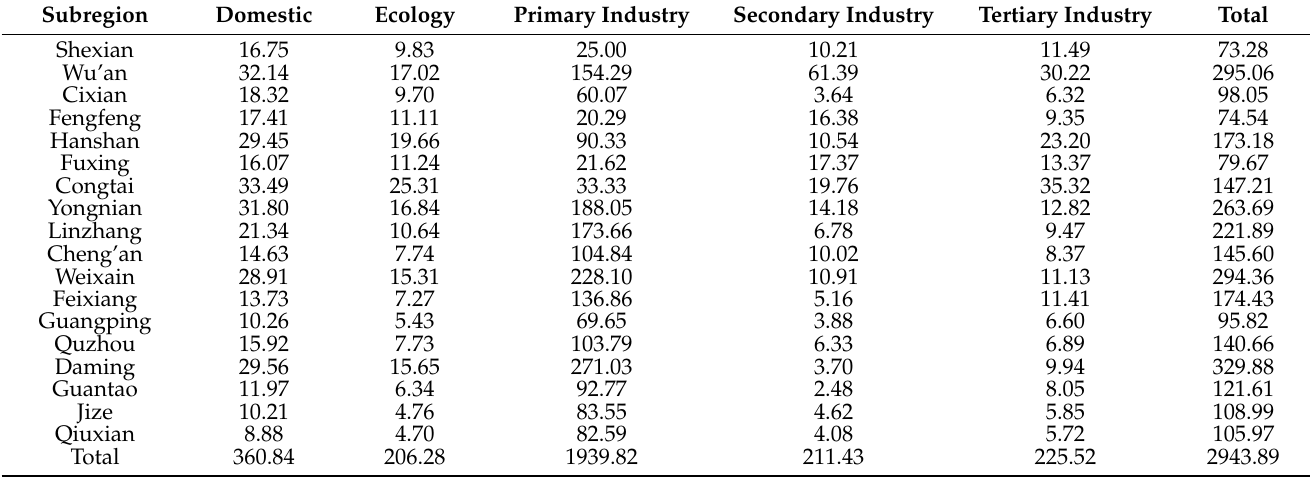
Table 1. Forecast results of water demand of different industries in Handan in 2025 (P = 50%; 10 6 m 3 ).